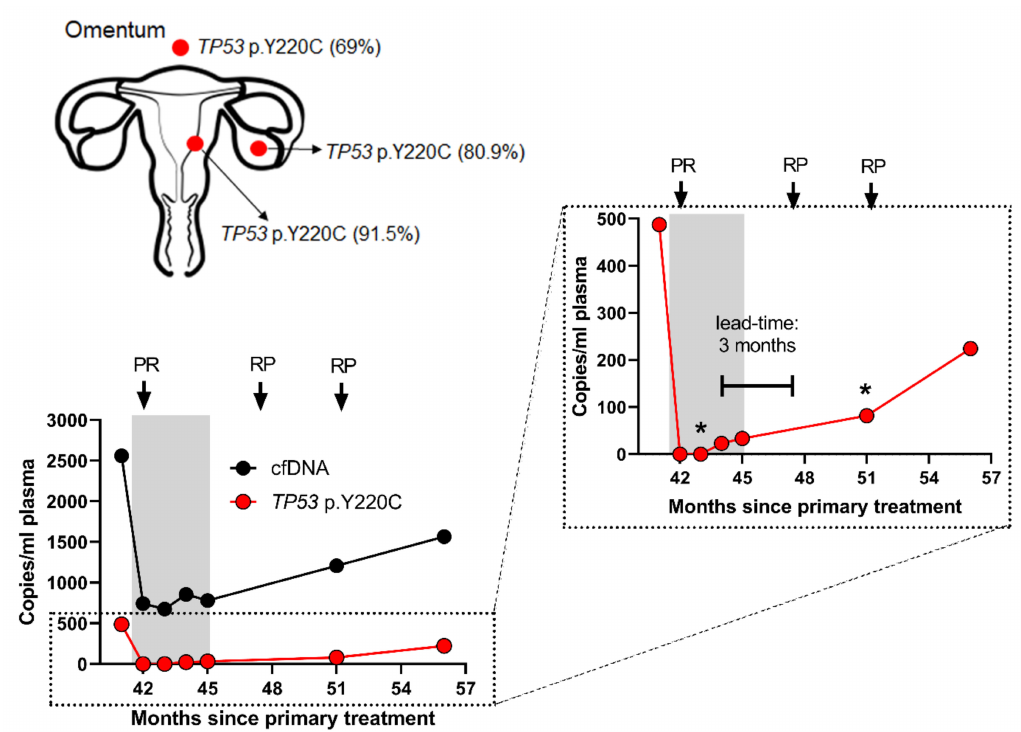
Figure 2. Multiregional sampling from patient 5, alongside the respective variant allele frequencies of the major driver mutation, TP53 p.Y220C, identified in the primary tumor sample (located in the endometrium), local metastatic lesion (located in the ovary) and the distal metastatic lesion (located in the omentum). The levels of cell-free DNA (cfDNA) and ctDNA in pre-treatment and post-treatment plasma samples are shown in the accompanying left-hand graph, clearly demonstrating a rise in ctDNA levels 3 months prior to radiological relapse (right-hand). * samples analyzed exclusively by digital droplet PCR (ddPCR). Grey shaded area indicates treatment with carboplatin and paclitaxel. PR = partial response; RP = radiological